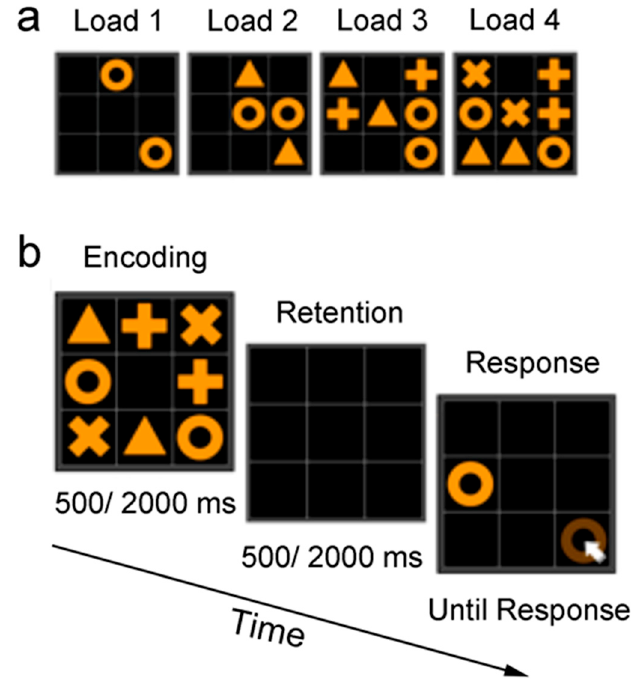
Figure 1. Stimuli ( a ) and the workflow of an example trial ( b ). Memory load was manipulated by varying the number of shape pairs. The circle and white arrow in the right–bottom cell is illustrated to show the correct response for the current trial but was not presented in the experiment.